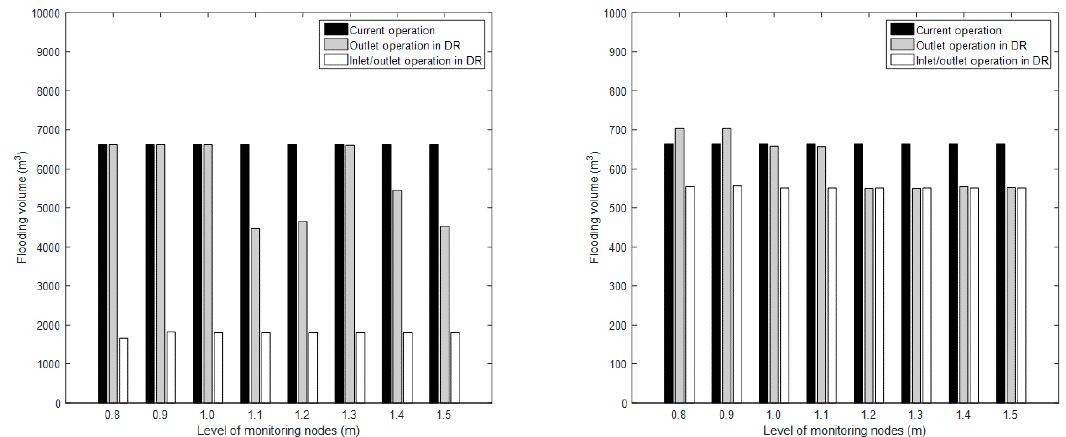
Figure 5. Flooding volumes compared to the level of monitoring nodes for three DR operation methods: current operation (black); outlet operation (grey); and combined inlet/outlet operation (white).